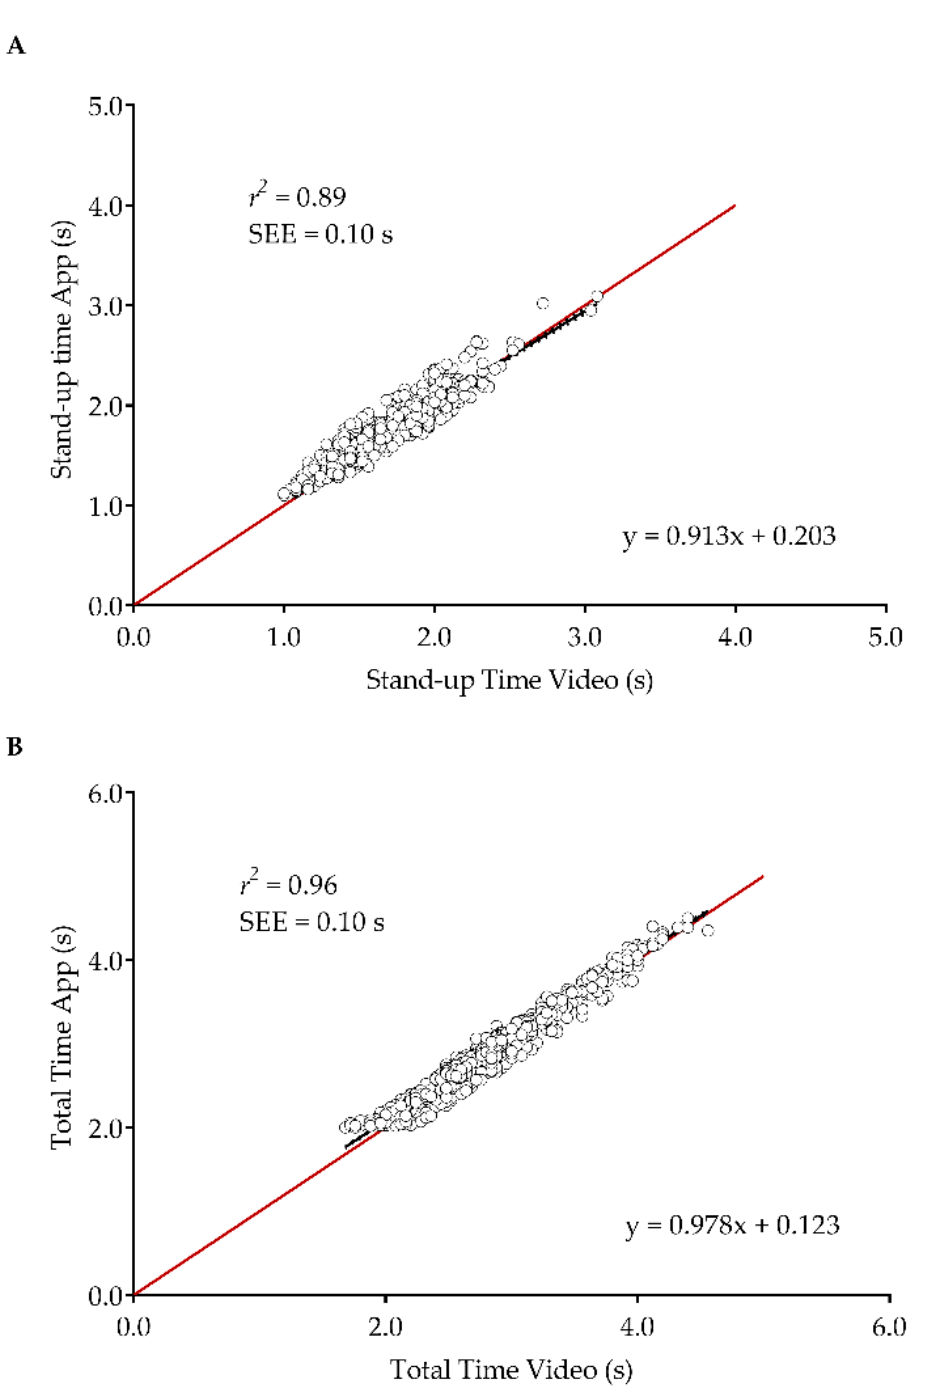
Figure 4. Linear regression between the mobile application and video-camera for the stand-up time ( A ) and total time ( B ); r 2 : coefficient of determination; the black lines indicate the regression line, while the red lines indicate the line of 45°; dotted lines indicate 95% confidence intervals.